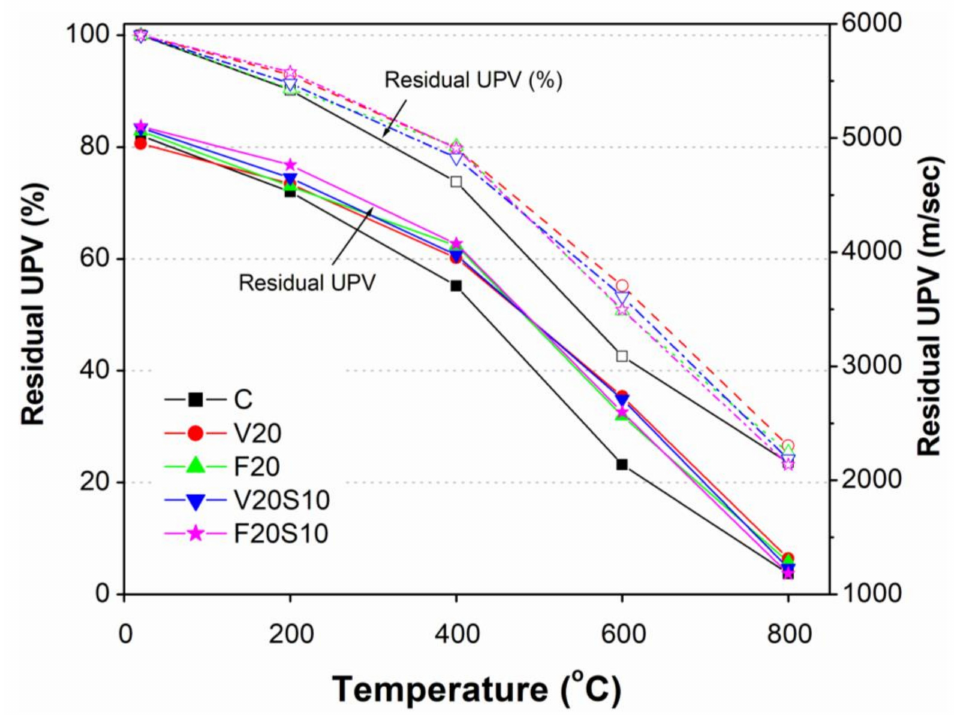
Figure 10. Comparison of residual UPV of VA concretes with those of CC and reference FA